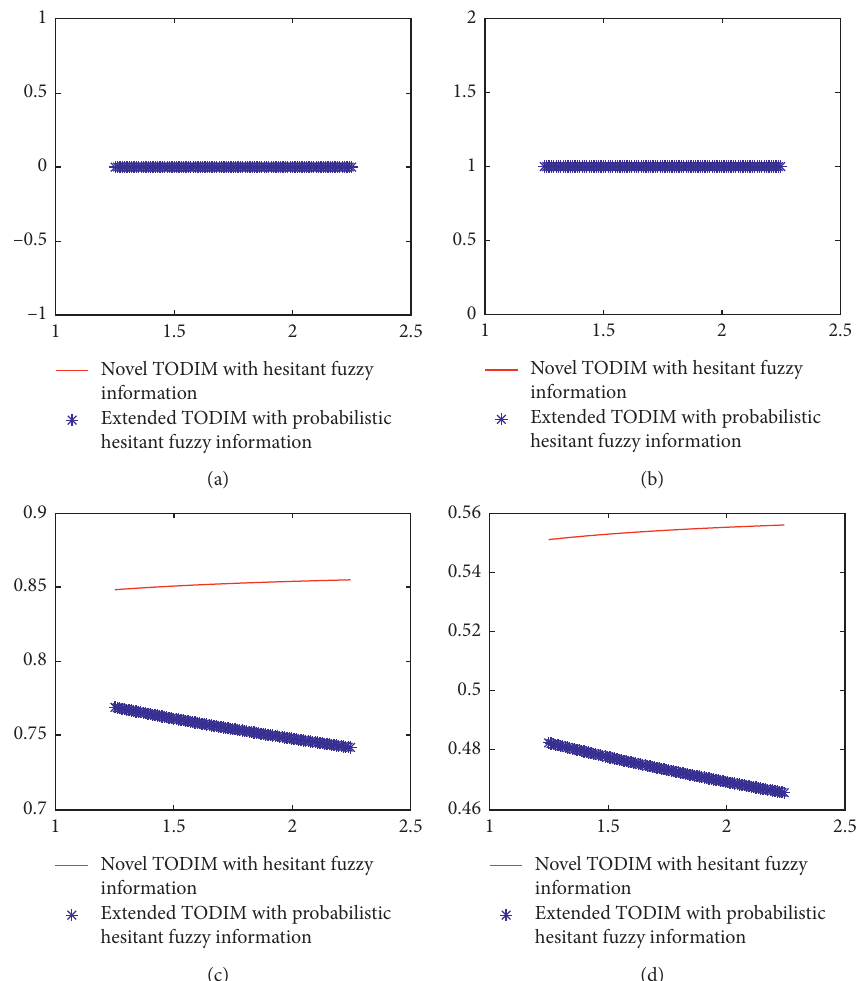
Figure 3: Sensitivity analysis with hesitant fuzzy information. 1 . 25 ≤ λ ≤ 2 . 25, α � β � 0 . 88, δ � 0 . 69, and c � 0 . 61. (a) A